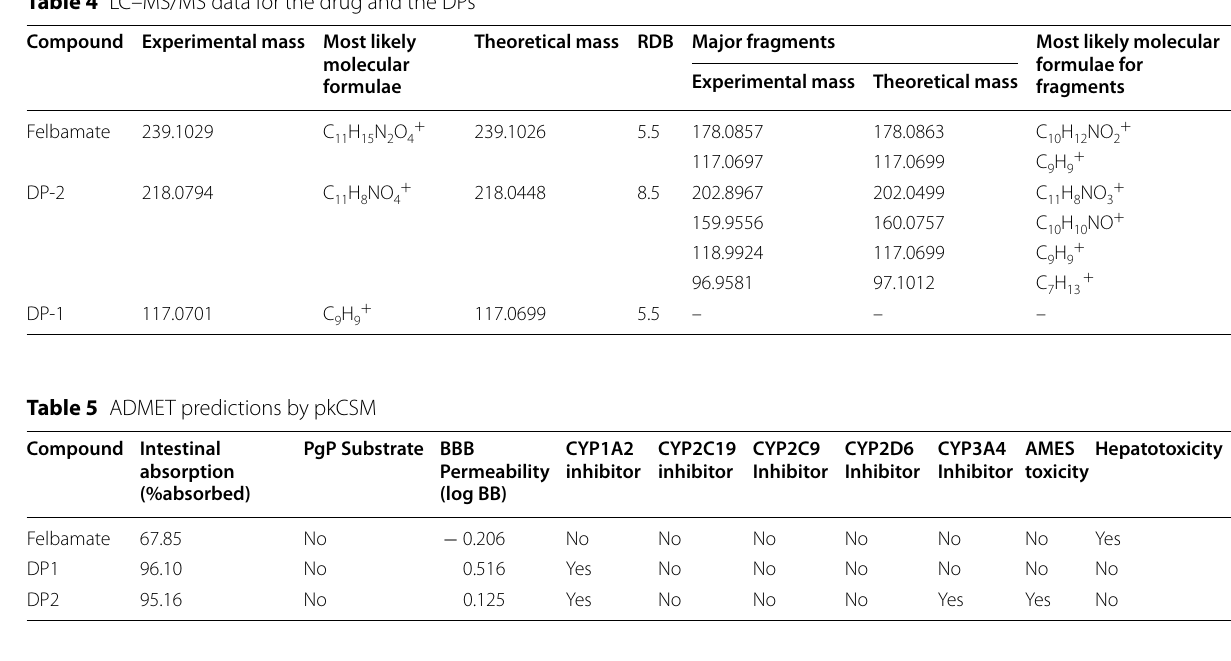
Table 4 LC–MS/MS data for the drug and the DPs Compound Experimental mass Most likely Theoretical mass RDB Major fragments Most likely molecular molecular formulae